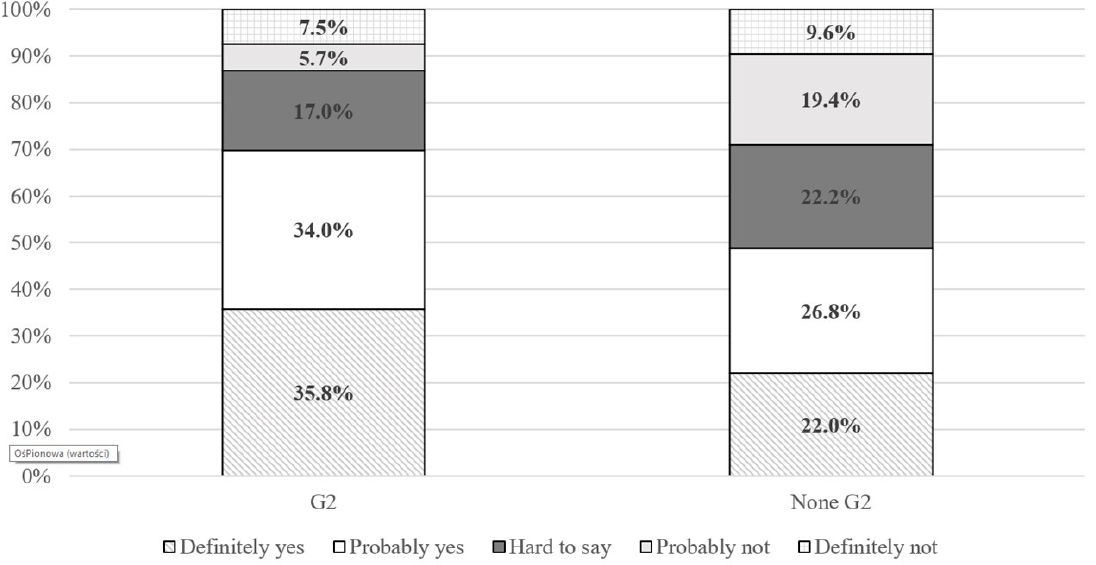
Figure 2. Distributions of responses to the question “In general, are you satisfied with your life?”, contrasting members of G1 with all other respondents (G1, n = 159; Non-G1, n = 842).